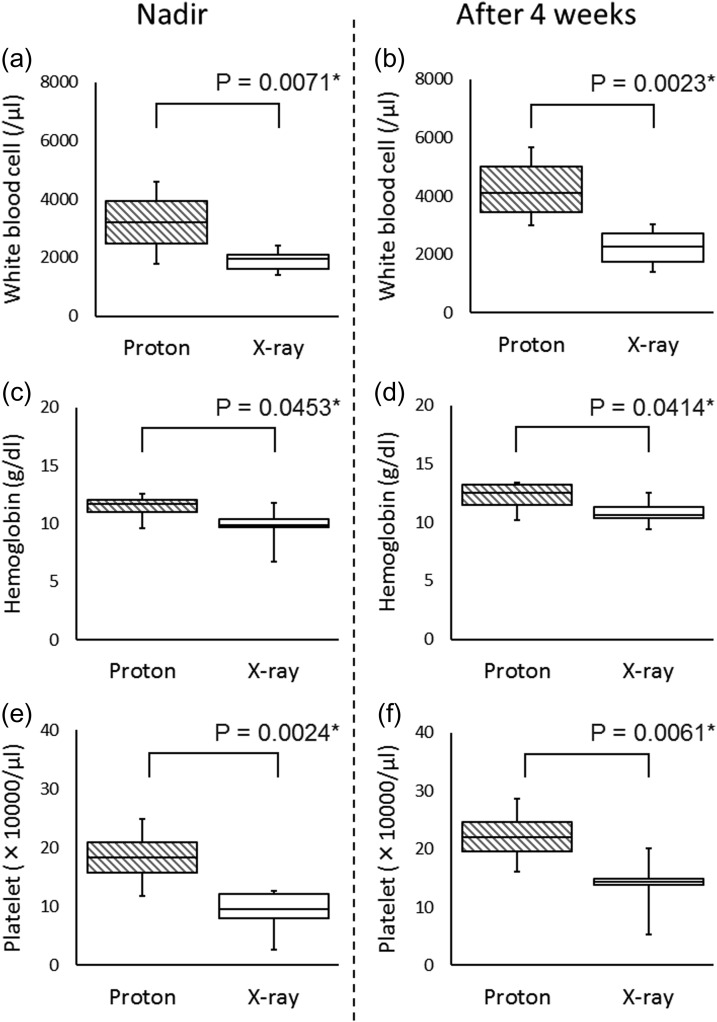
Comparison of acute hematological toxicity between AYA patients who received ipCSI and AYA patients who received photon CSI. (a) The nadir of white blood cell counts during the 4 week period after the end of CSI, (b) the white cell blood counts at 4 weeks after the end of CSI, (c) the nadir of hemoglobin during the 4 week period after the end of CSI, and (d) the hemoglobin at 4 weeks after the end of CSI, (e) the nadir of platelet counts during the 4 week period after the end of CSI, and (f) the platelet counts at 4 weeks after the end of CSI.